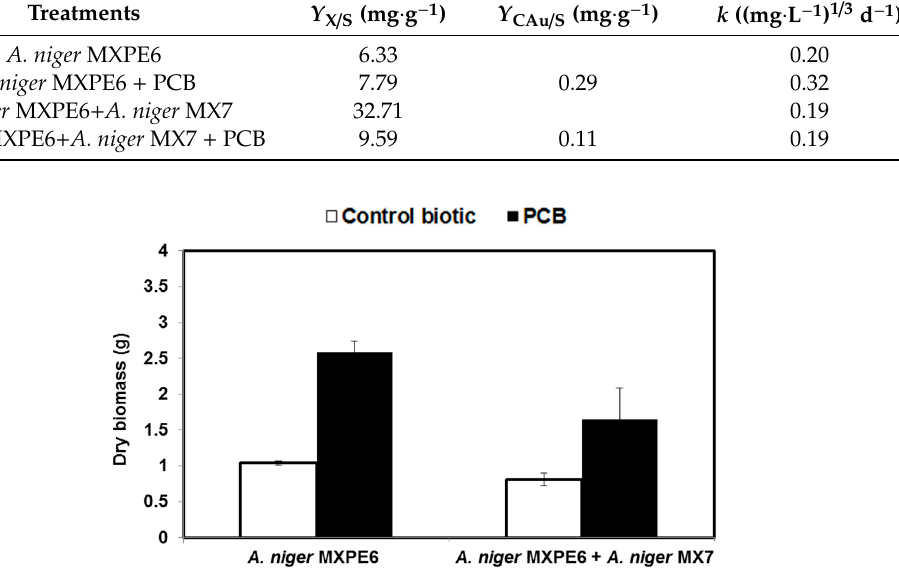
Figure 3. Dry biomass of treatments with and without PCB. Data are given as means ± standard error; n = 3.